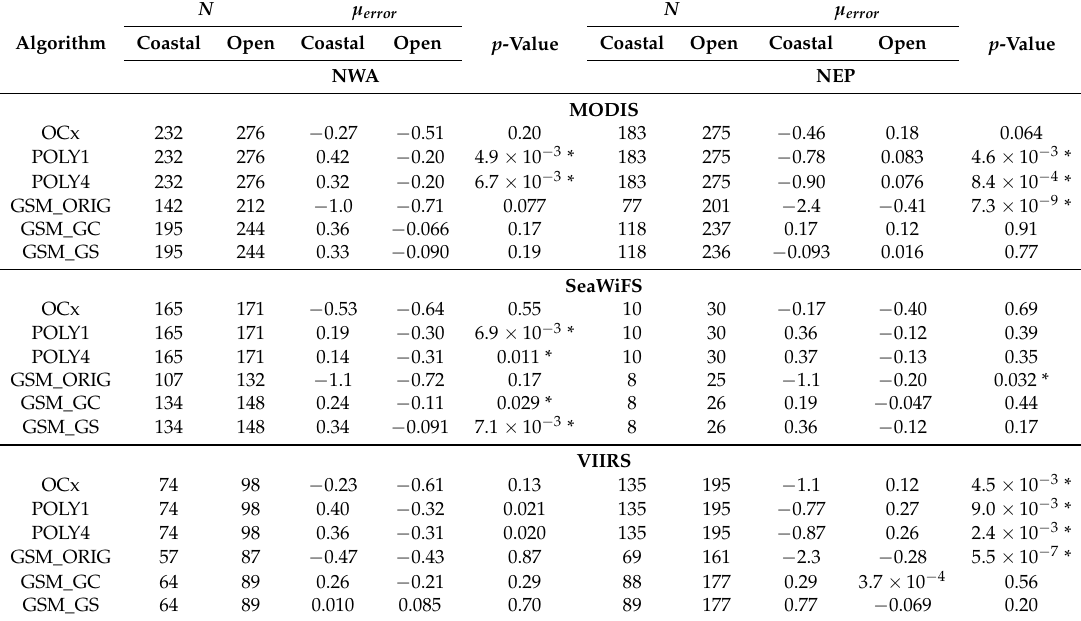
Table A5. Results of the t -test to check for differences in µ error between coastal (bathymetry <= 200m) and open ocean (>200m) subsets. * = statistically significant ( p -value < 0.05).